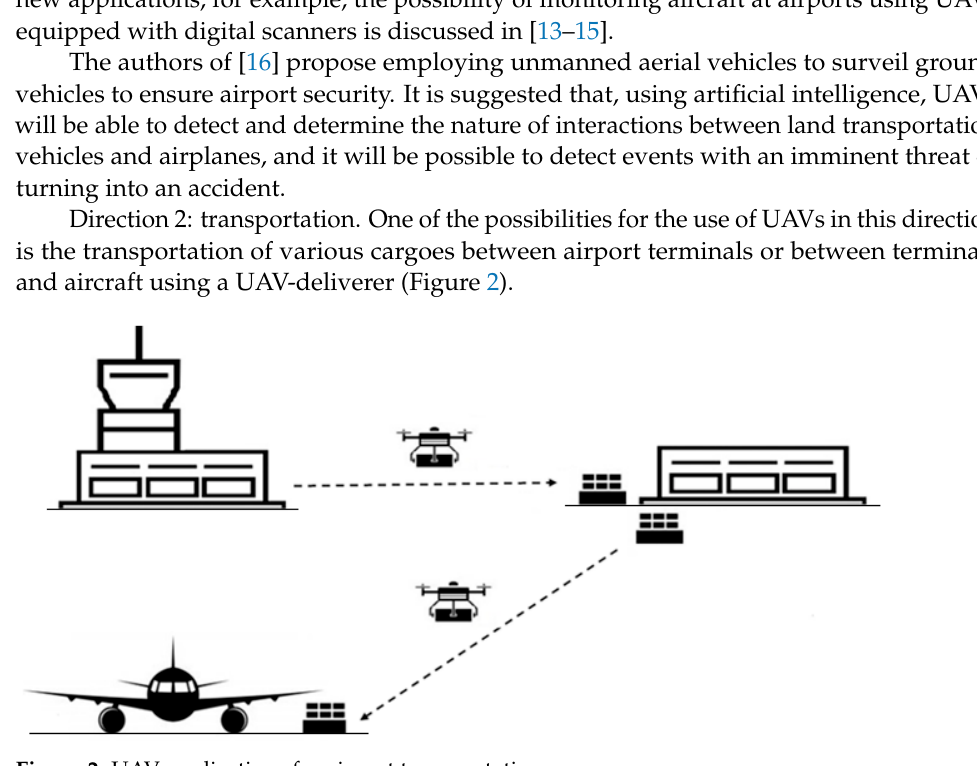
Figure 2. UAV applications for airport transportation.